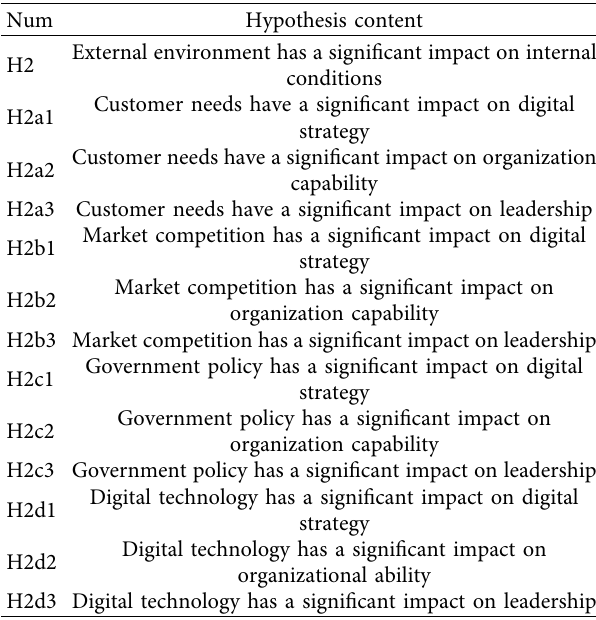
Table 1: Subhypotheses of